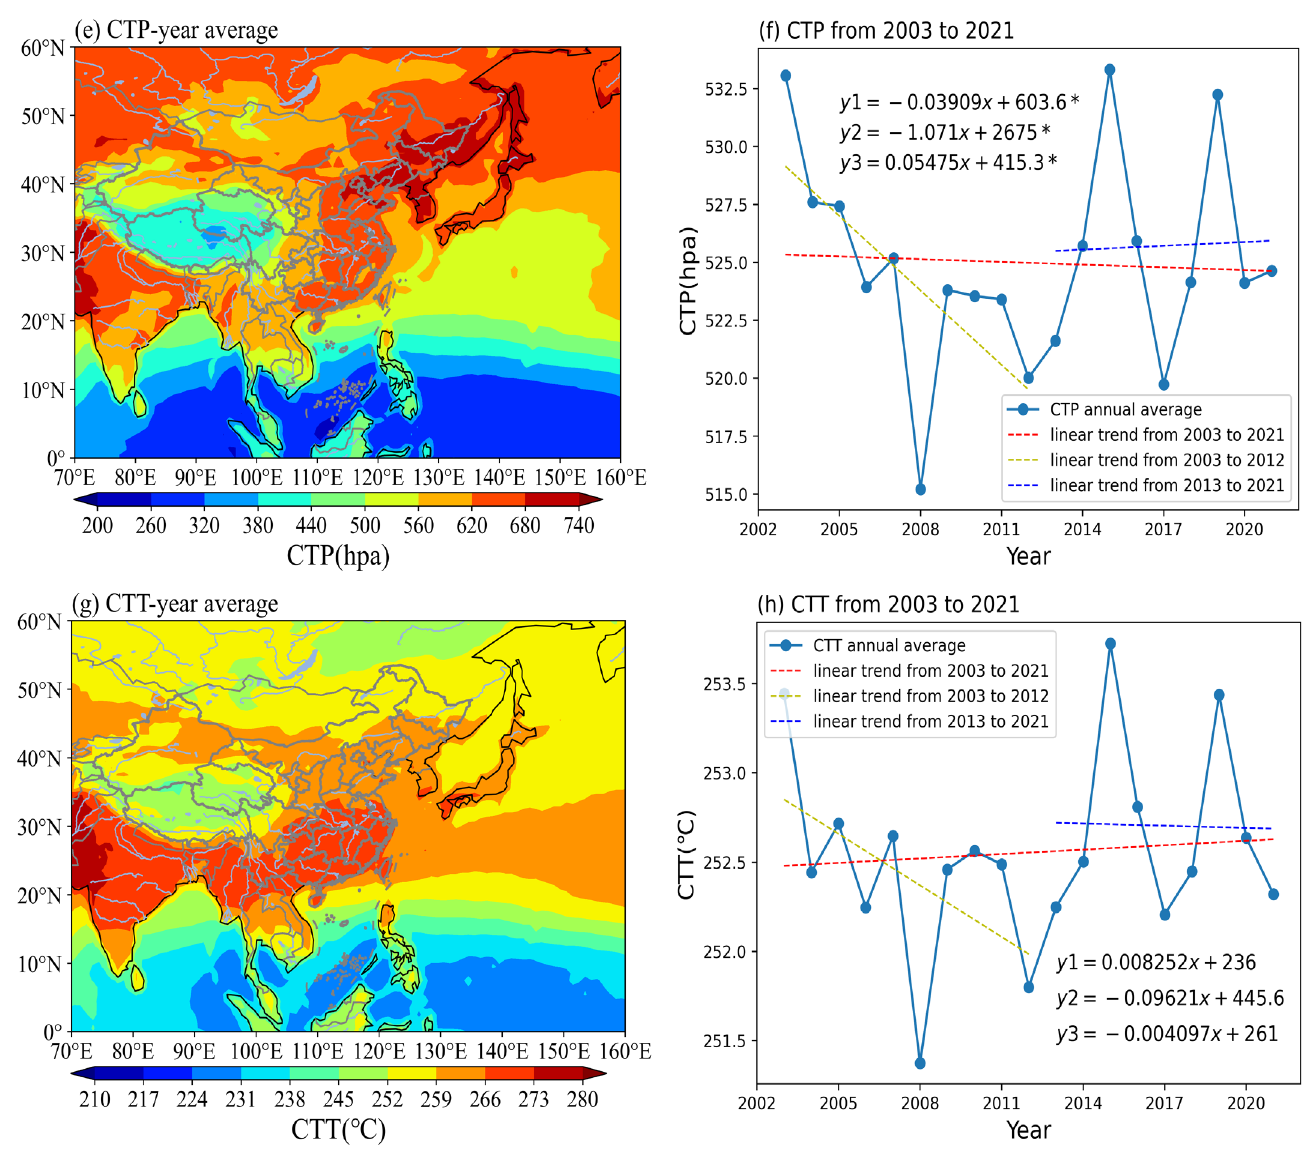
Figure 8. The parameters of ( a , c , e , g ) are spatial distribution, and the parameters of ( b , d , f , h ) are time variation .